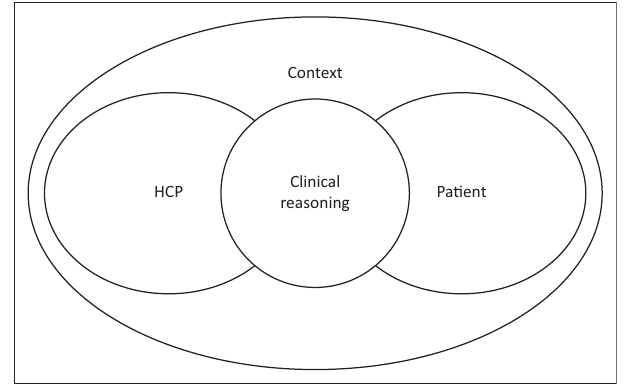
FIGURE 5: Venn diagram representing clinical